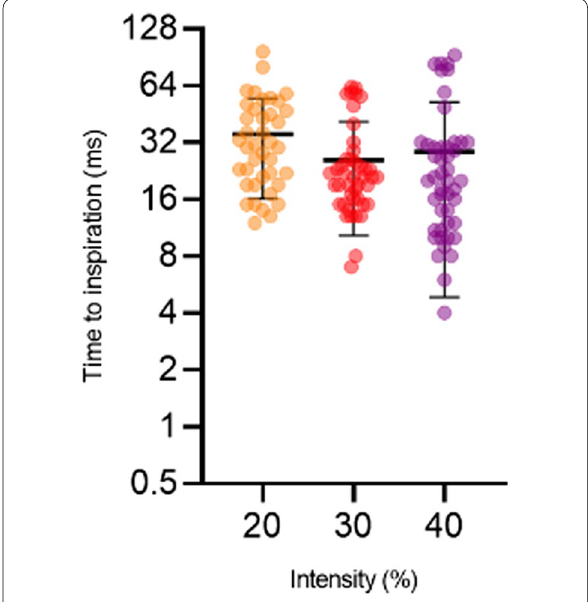
Figure 1. Logarithmic presentation of time (ms) to inspiration (flow 0.5 L/min) after bilateral non-invasive electromagnetic phrenic ≥ nerve stimulation with 20% (orange), 30% (red), 40% (violet) intensity. Mean and standard deviation are